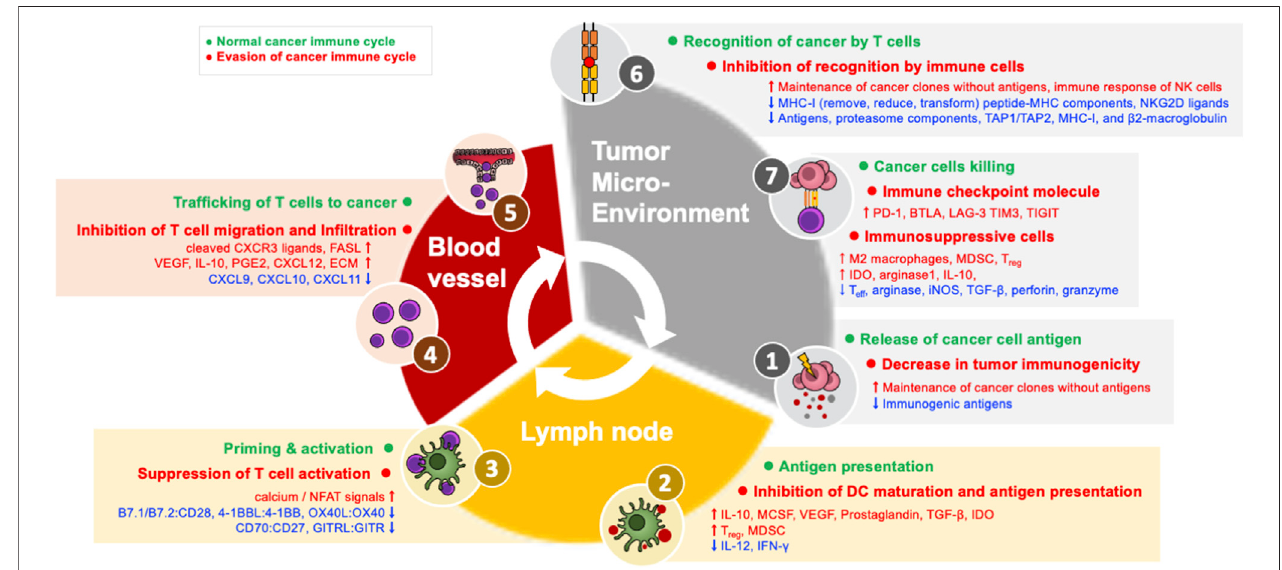
FIGURE 1 | Evasion machanisms in the cancer immune